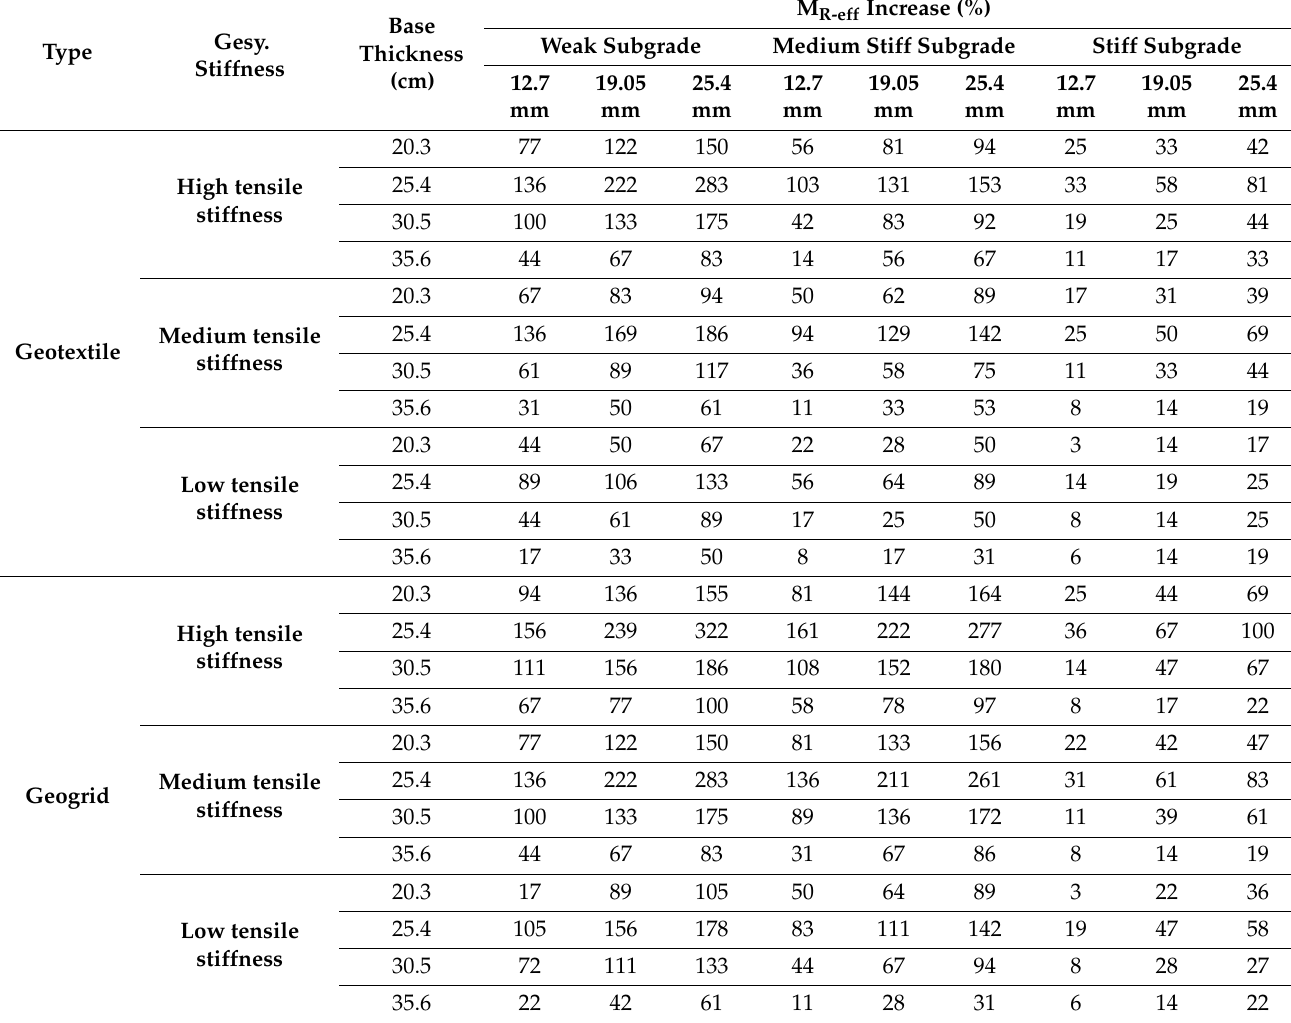
Table 7. Derived M R-eff increased values for reinforced cases over a weak subgrade